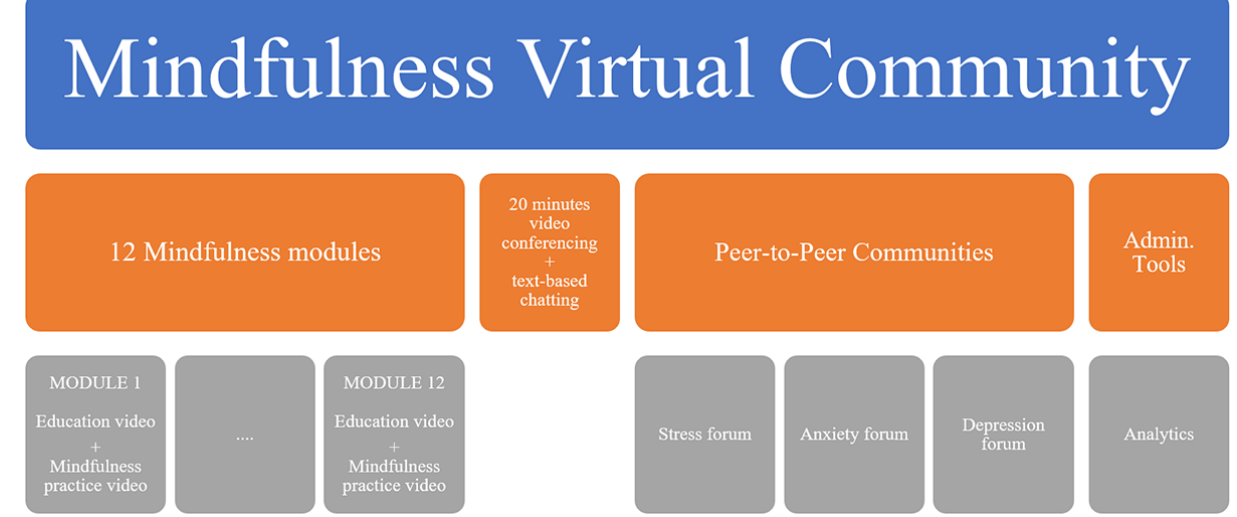
Figure 1. The mindfulness virtual community